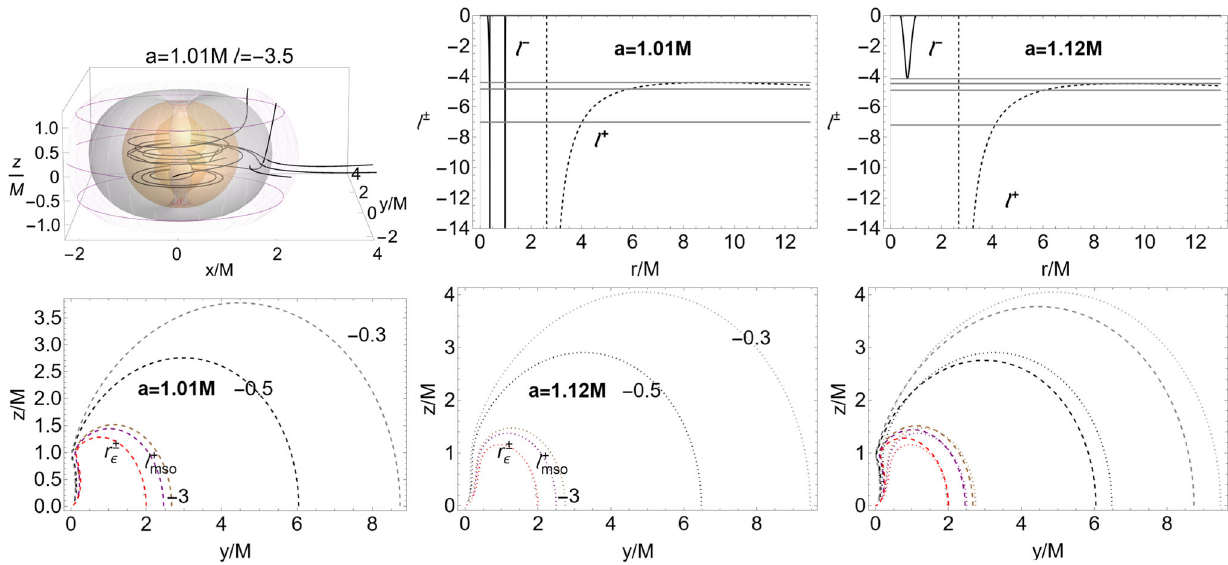
Fig. 27 Analysis of the inversion sphere for low angular momenta spheres and out – going trajectory crossing the inversion sphere. Gray counter-rotating tori (cid:6) − ∈] (cid:6) + mso , 0 [ in the ergoregion of NSs with region is the ergosurfaces orange region is the counter-rotating torus in (cid:6) the ergoregion. Upper center and right panel: specific angular momenta a ∈ [ 0 , a 2 ] . There is r = z 2 + y 2 and σ ≡ sin 2 θ = y 2 /( z 2 + y 2 ) . I (cid:6) ± < 0 as functions of r / M for selected spins signed on the panel. Radii r ± (cid:11) are the outer and inner ergosurfaces. Notation mso refers the ,(cid:6) + ) . Below left and center panel, the Gray lines are (cid:6) ± mso and ((cid:6) + marginally stable circular orbit, mbo to marginally bounded orbit and γ mbo (γ) to the marginally circular orbit. Upper left panel: purple surface is ergosurfaces and inversion spheres for selected values of (cid:6) < 0 signed on the curves and for the NSs spins reported on the panels. Bottom right the inversion sphere at specific angular momentum (cid:6) − = − 3 . 5 > (cid:6) − mso . panel shows super-imposition of the left and center Black lines are test particles ingoing trajectories crossing the inversion